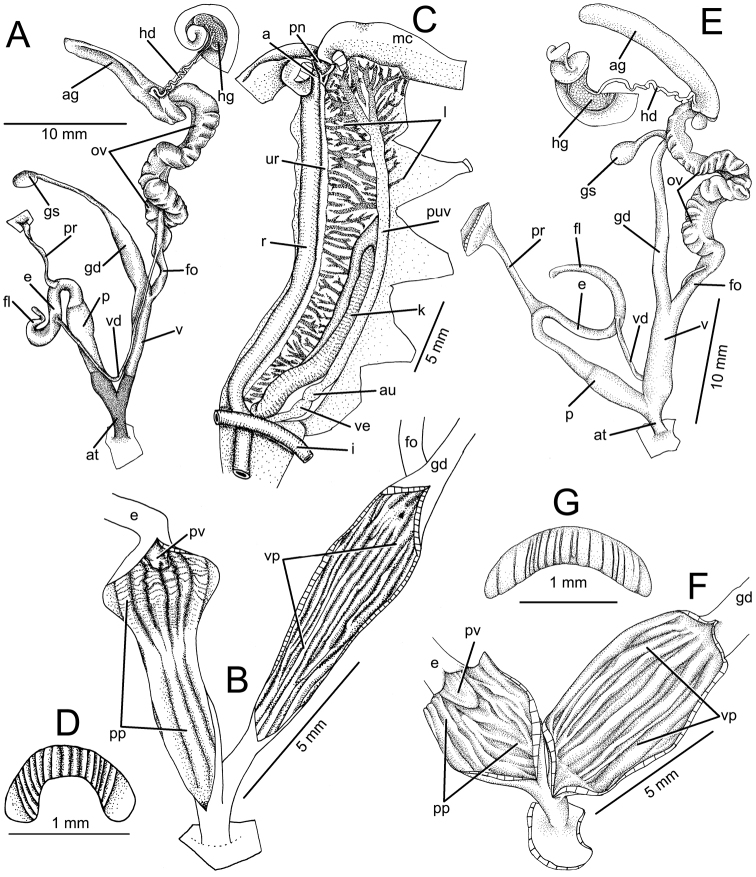
A–DGanesella
carinella from Saraburi A general view of genital system B internal structure of penis and vagina C pallial system and pulmonary cavity and D jaw E–GGanesella
rhombostoma from Srakaeo E general view of genital system F internal structure of penis and vagina and G jaw.